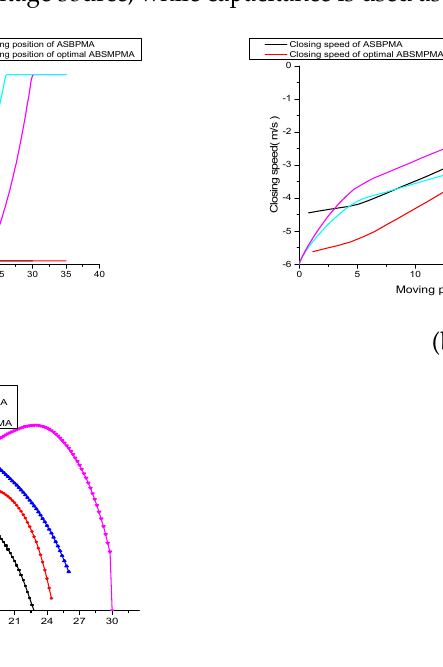
Figure 10. The optimized results. ( a ) The optimal average opening speed per generation and the average value of the average opening speed per generation. ( b ) The average opening speed char- acteristics within constraint conditions. ( c ) The average closing speed characteristics within con- straint conditions.